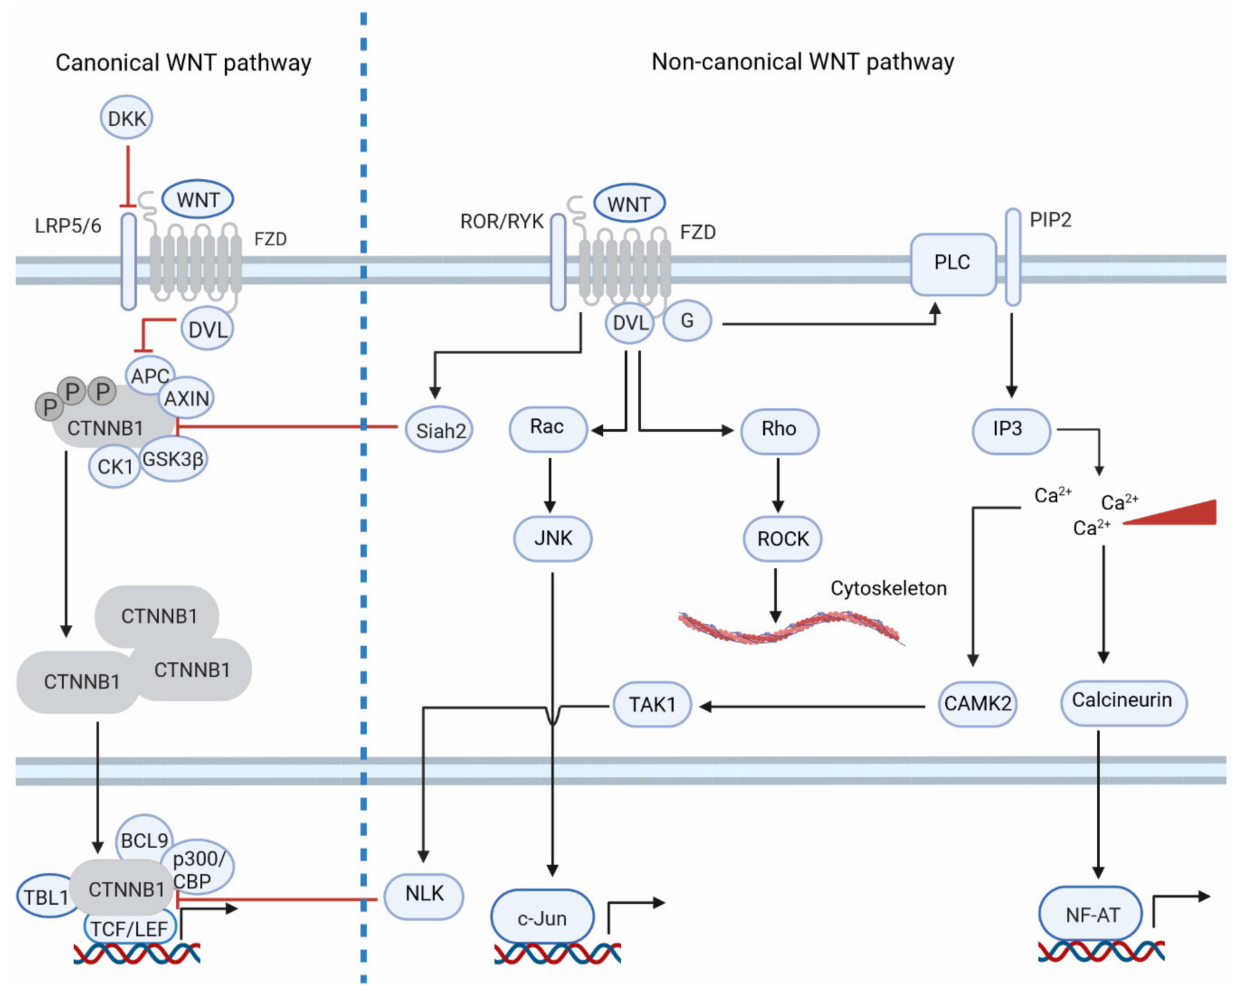
Figure 1. Non-canonical WNT pathways inhibit canonical WNT signaling on several levels. Canonical and non-canonical WNT pathways are usually activated by different sets of WNT ligands and FZD receptors. Upon activation of the canonical pathway, DVL is recruited to FZD and AXIN to LRP5/6, resulting in inhibition of the β -catenin destruction complex. B-catenin then accumulates in the cytoplasm and enters the nucleus, where it activates TCF/LEF dependent transcription. The non- canonical branch can be divided into the WNT/PCP (planar cell polarity) and WNT/Ca 2+ pathways. WNT/PCP signaling regulates cell migration via Rho and ROCK kinases and adhesion via JNK kinase. Activation of WNT/Ca 2+ signaling induces calcineurin, which leads to the transcription of NF-AT genes. Both non-canonical branches can inhibit canonical signaling: WNT/PCP via Siah2 E3 ligase, which induces β -catenin degradation in a GSK-3 β -independent manner; WNT/Ca 2+ via TAK1 and NLK